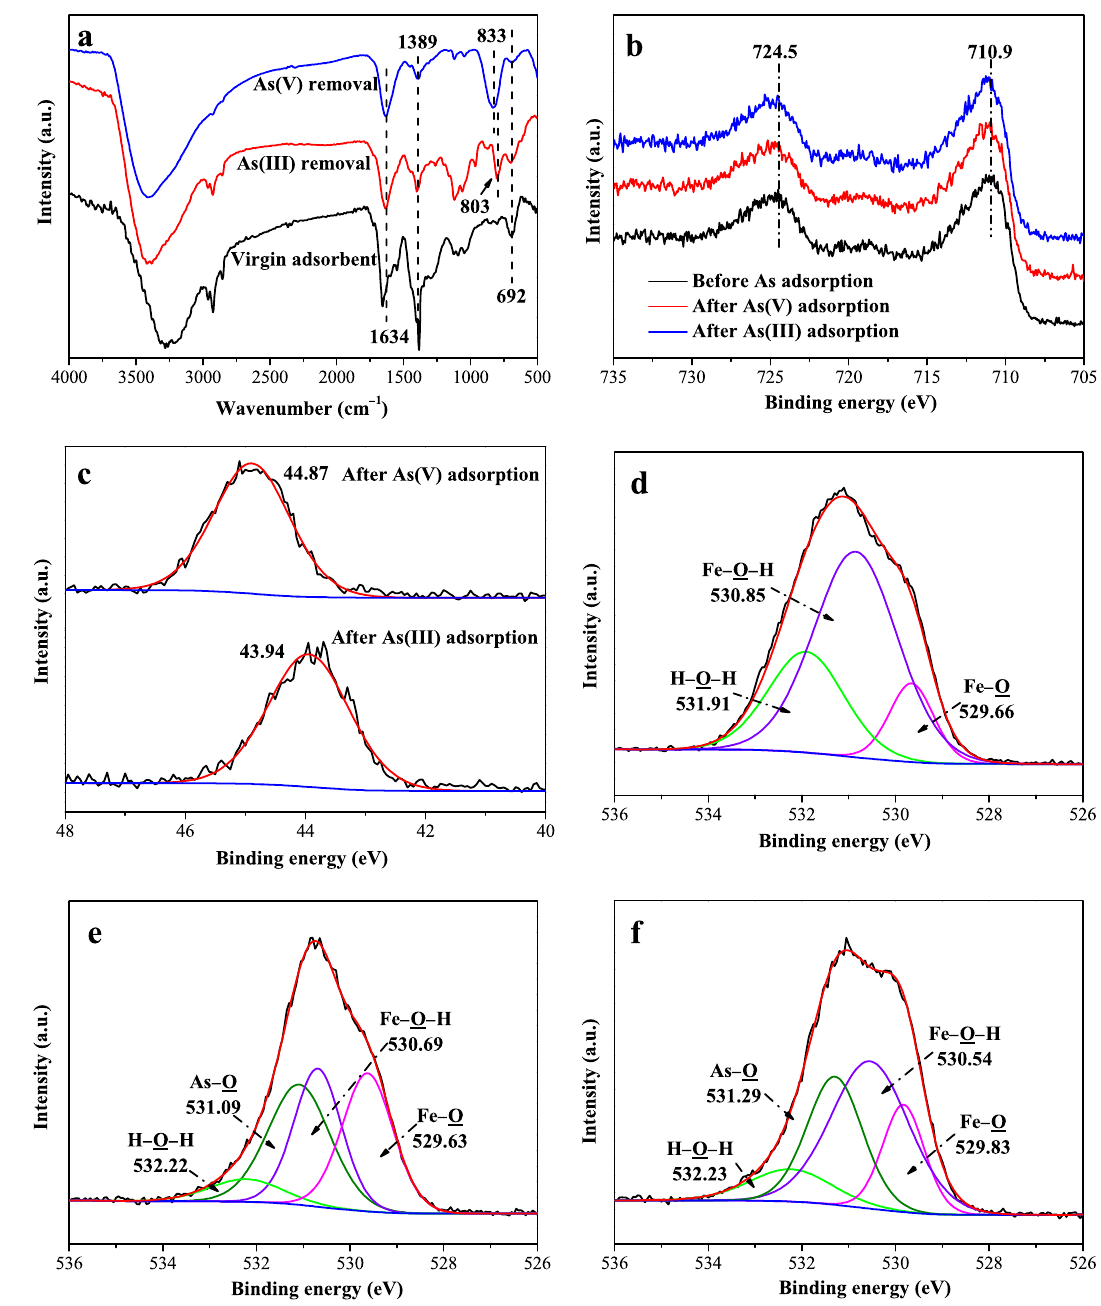
2p ( b ), As 3d ( c ), O 1s ( d , before As adsorption; e , As(V) adsorption; f , As(III) adsorption) high-resolution XPS spectra before and after As(V) and As(III)